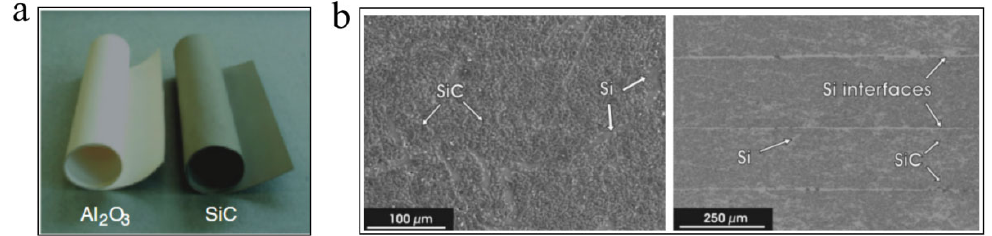
Fig. 18 LOM fabricated SiC ceramic: (a) Preceramic papers. Reproduced with permission from Ref. [65], © The American Ceramic Society 2008. (b) Layer-by-layer microstructure. Reproduced with permission from Ref. [66], © WILEY ‐ VCH Verlag GmbH & Co. KGaA, Weinheim